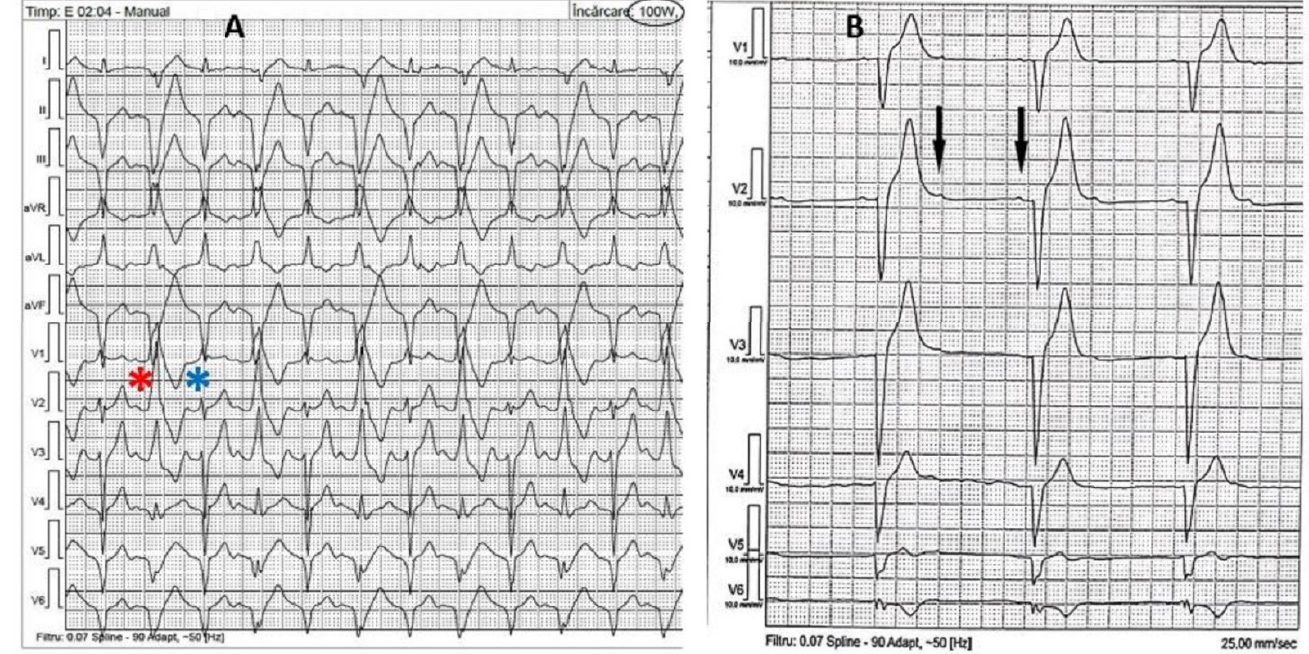
Figure 4. ( A ) ECG monitoring during ET: at 100 W, an alternative QRS morphology with narrow QRS (fusion pacing—blue asterisk) and large QRS (RBBB morphology due to complete LV capture—red asterisk) can be seen. ( B ) At pacemaker inhibition, a 2:1 AV block can be noted. Table 3. Comparative data regarding the main clinical and echocardiographical parameters at baseline versus